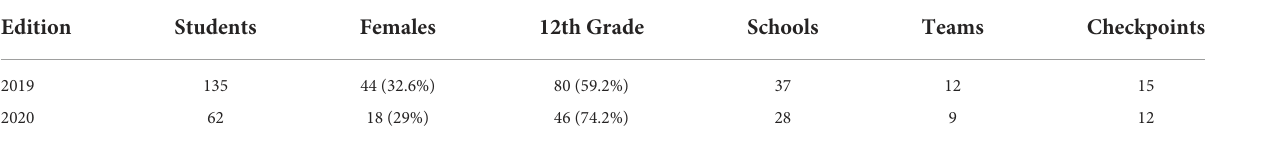
TABLE 3 Basic facts about the two reported